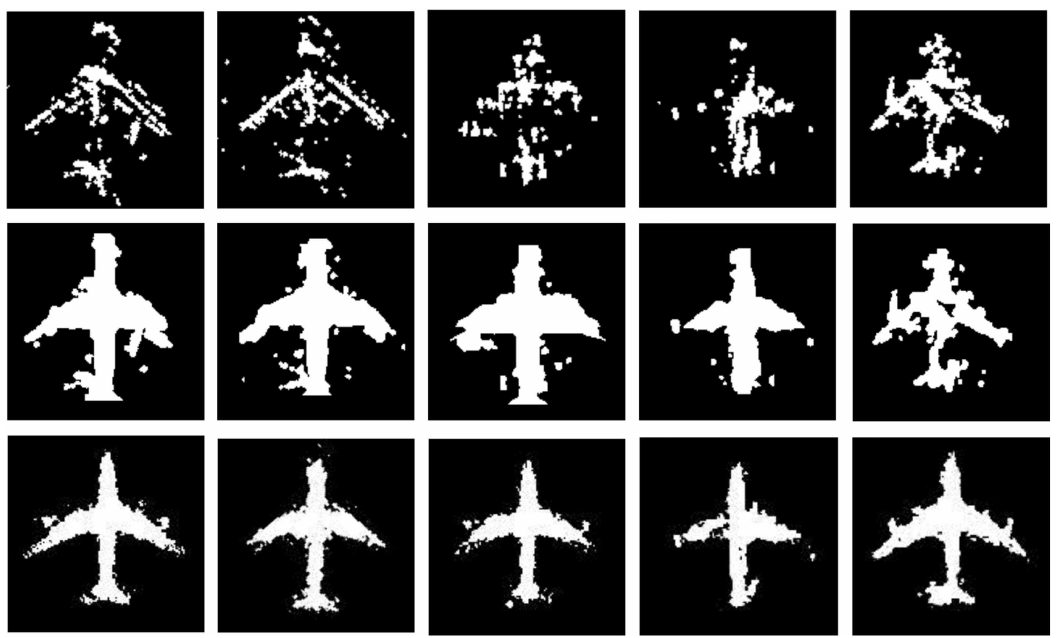
Figure 14. Reconstruction results. Top row: Test data after turning the aircraft into the same pose. Middle row: Reconstruction results of SGACM. Bottom row: Reconstruction results of our